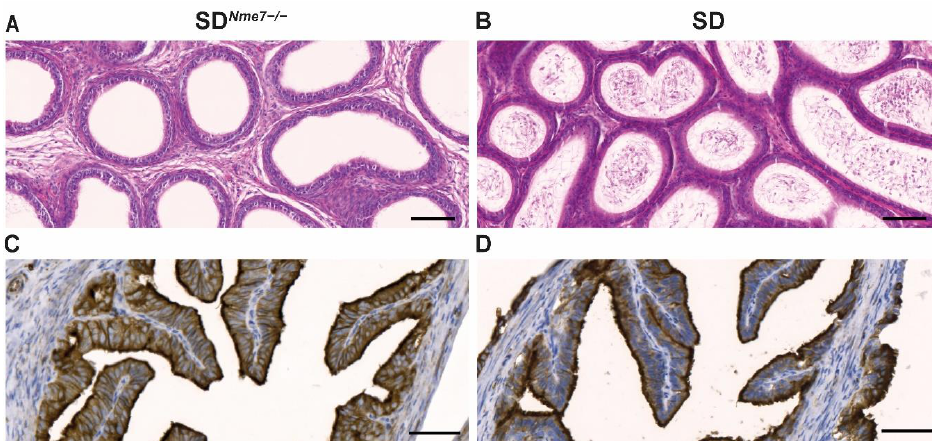
Figure 6. Epididymis (hematoxylin-eosin-stained) of SD Nme7 − / − male rats showing an empty epididymal tubule lumen documenting aspermia ( A ) compared to the normal appearance of sperm in the epididymal tubule lumen in SD control male rats ( B ). Acetylated- α -tubulin staining of a transversally sectioned oviduct in SD Nme7 − / − female rats ( C ) and SD ( D ) female rats. The bars indicate 100 µm for ( A , B ), 50 µm for ( C , D ).